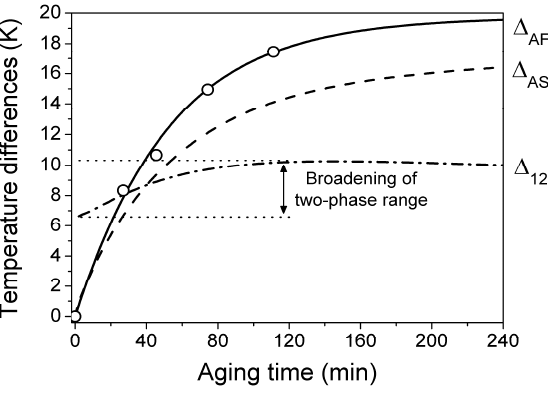
Figure 5. Time evolution of the austenite start (dotted line), austenite finish (solid line), and two-phase temperature range (dashed-dotted line). The experimental values (circles) for the austenite finish temperature are taken from [57] and used for the evaluation of relaxation time and saturation value of stabilizing internal